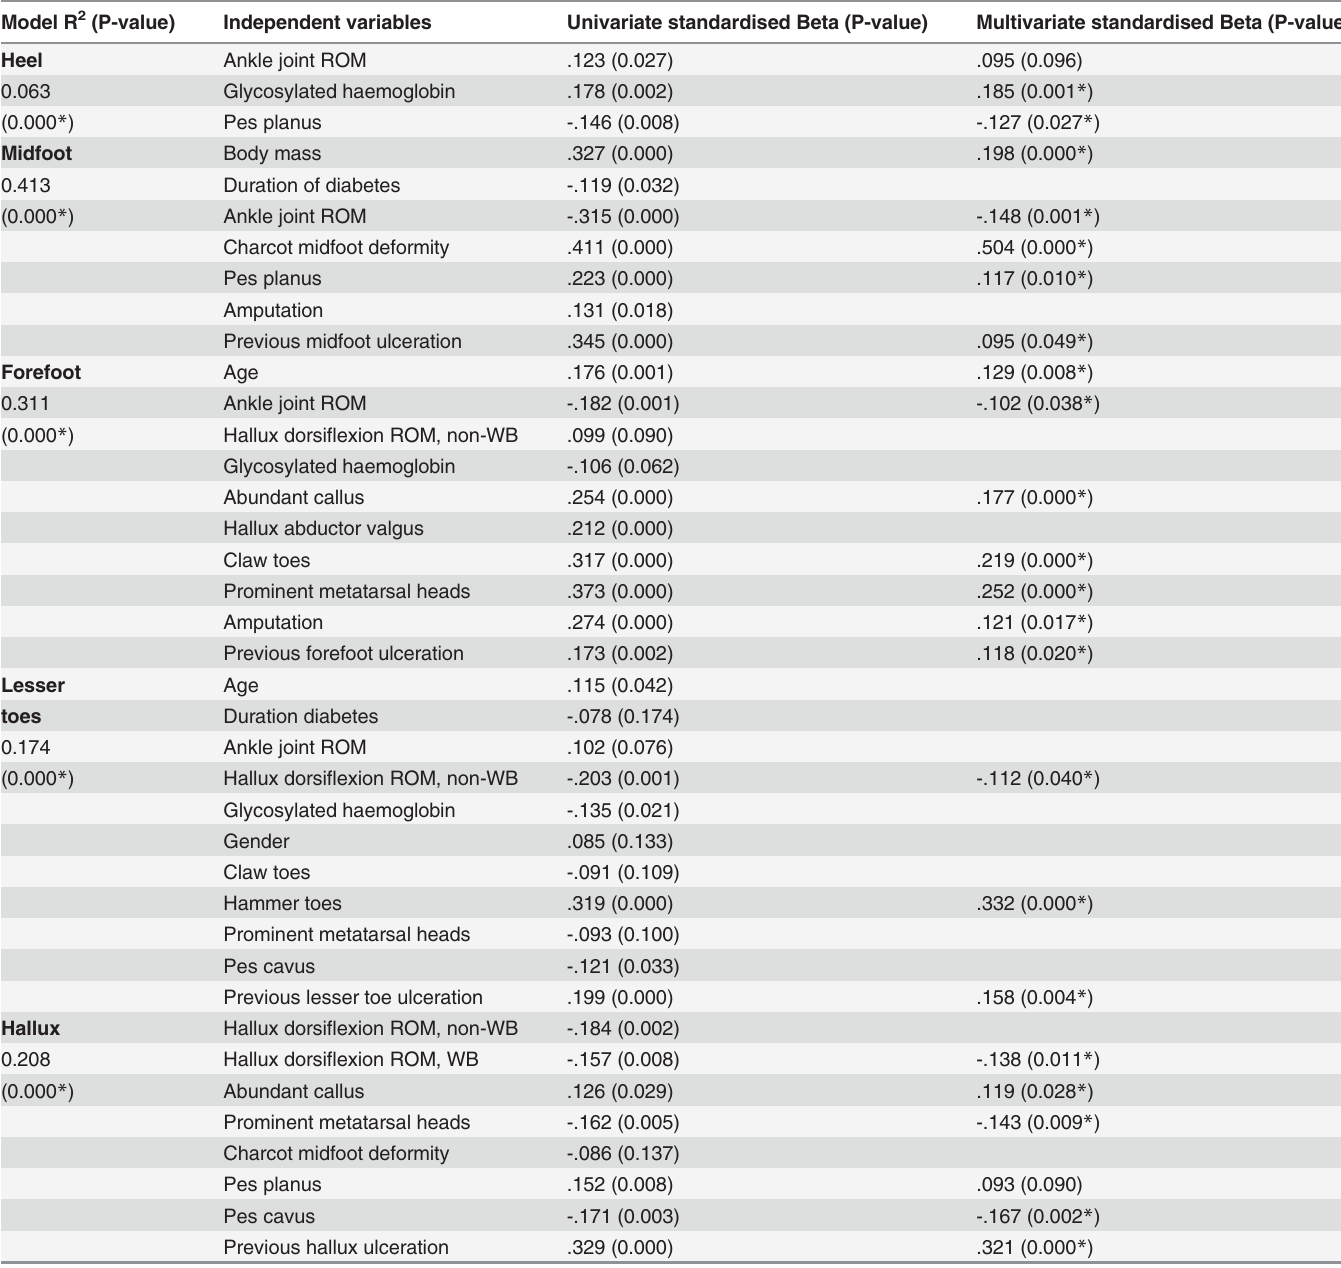
Table 4. Univariate and multivariate regression analyses. Model R 2